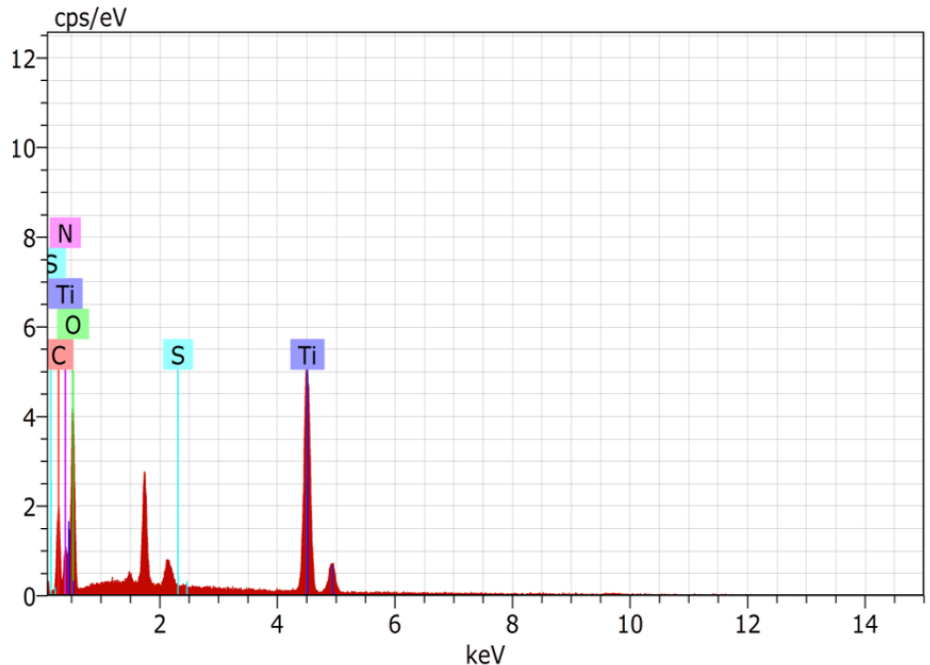
Figure 15. EDX of the functionalized organic-inorganic nano composites (12) .